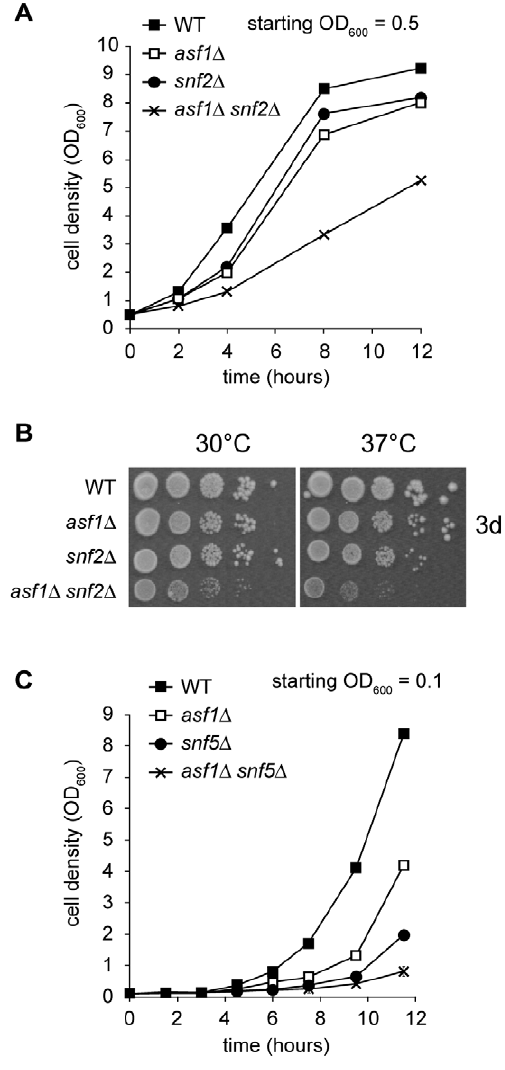
Figure 4. ASF1 shows synthetic sick interactions with compo- nents of the SWI/SNF complex. A. asf1 D snf2 D double mutants are slower-growing than either single mutant. B. asf1 D snf2 D double mutants are slightly temperature-sensitive. Ten-fold serial dilutions of early log phase cells were photographed after 3 days of growth. C. asf1 D snf5 D double mutants are slower-growing than either single mutant. Averages of three independent asf1 D snf5 D isolates are shown, with error bars (under data point icons).